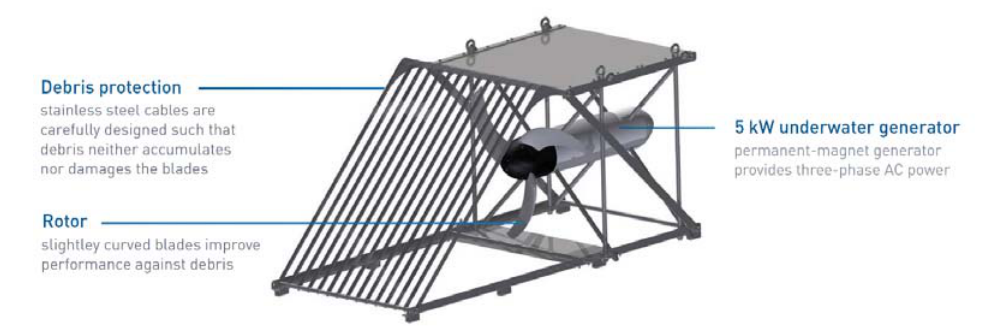
Figure 4. Kinetic turbine for deployment in canal (SHP SMART free stream turbine)